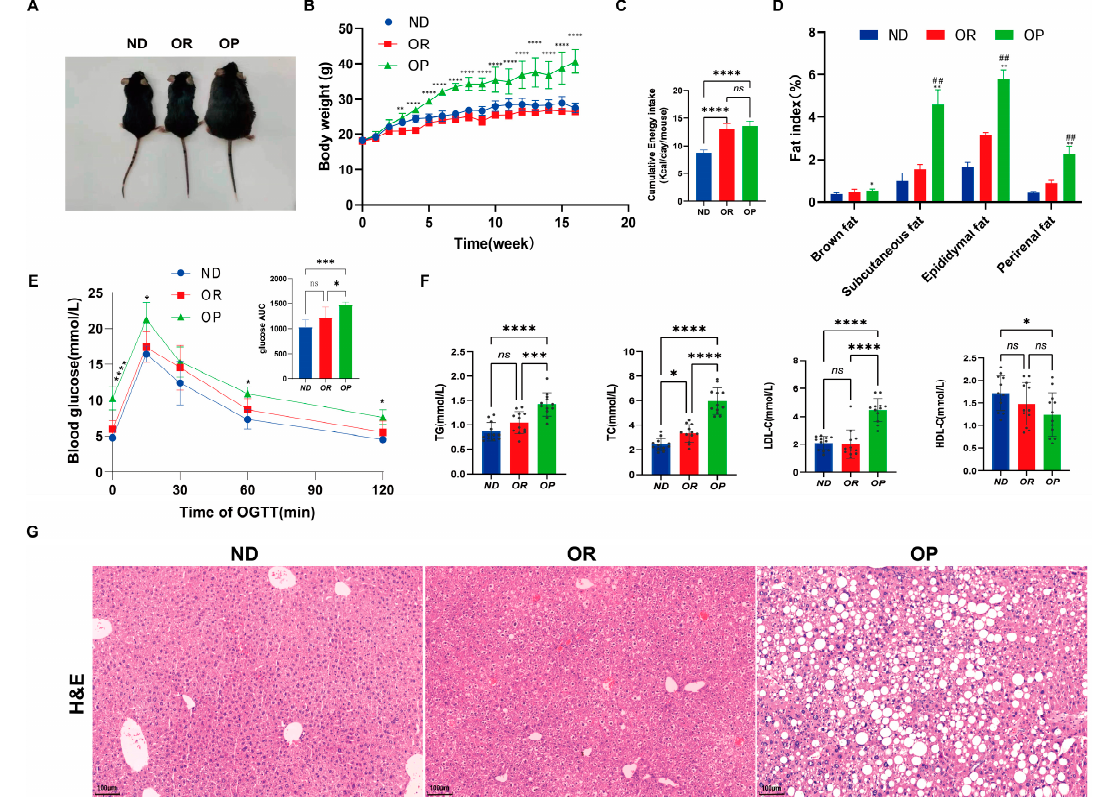
Figure 1. The physiological changes in the Normal diet (ND), obesity-prone (OP), and obesity- resistant (OR) groups. ( A ) Mice representative images. ( B ) Body weight ( n = 12 per group). ** p < 0.01 and **** p < 0.0001 vs. the OR group. ( C ) Energy intake. ( D ) Fat index. * p < 0.05 and ** p < 0.01 vs. the ND group; ## Fat index was significantly altered in OP relative to OR ( p < 0.01). ( E ) Blood glucose levels were measured by an oral glucose tolerance test (OGTT) performed during the 16 weeks of the experiment. * p < 0.05, *** p < 0.001 and **** p < 0.0001 vs. the OR group ( F ) Serum biochemical parameters. A sample is represented by each black dot. ( G ) Representative images of H&E staining of liver sections ( n = 6 per group). The scale bar for H&E staining represents 100 μ m. Data are expressed as the mean ± SD . **** p <0.0001, ***p<0.001 , ** p < 0.01 and * p < 0.05 were con- sidered signi fi cant. ns , not significant.